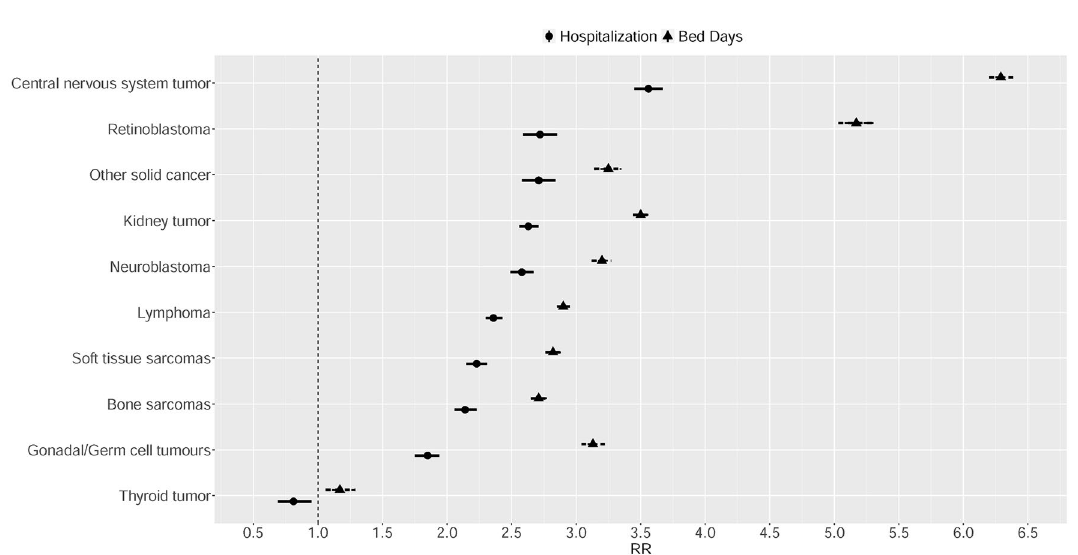
Figure 2. The relative hospitalisation ratio and the relative bed-day ratio by the type of primary